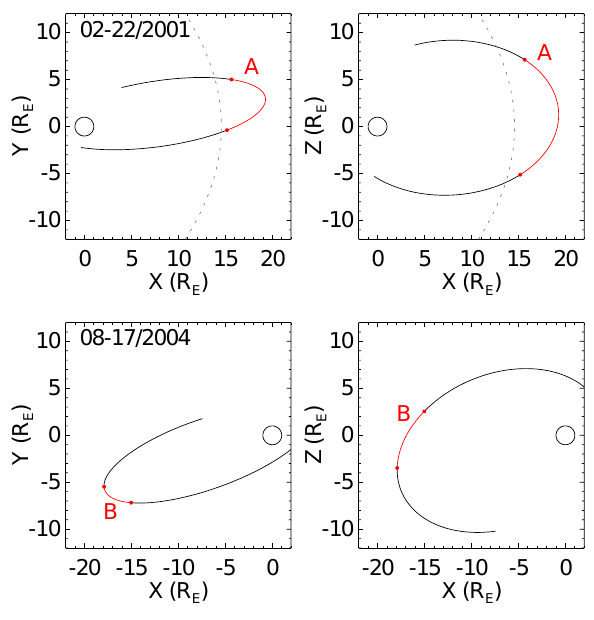
Fig. 1. Cluster orbits projected onto the x-y and x-z planes during the time period selected in this study. The upper panel shows the orbit when the Cluster was in the solar wind on 22 February 2001 (period A), and the lower panel in the magnetotail on 17 August 2004 (period B). The line segments marked by red color indicate the time periods selected in this study. In the upper panel the bow shock location is shown as the dashed